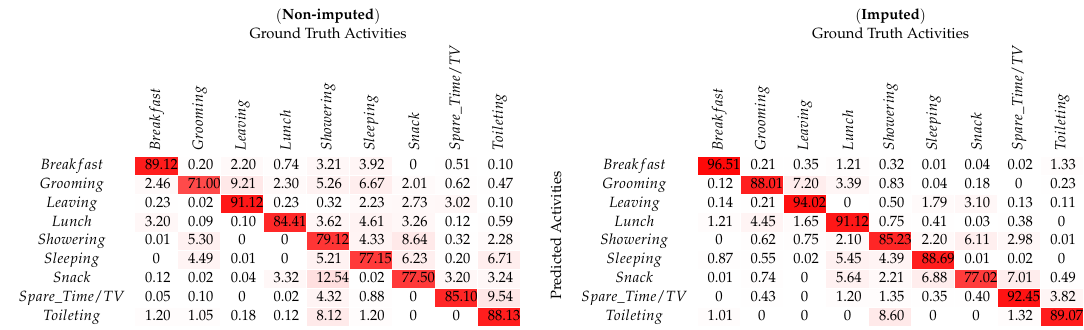
Table 4. Confusion matrix for per-class HAR using non-imputed & imputed UCI-ADL (OrdóñezA)